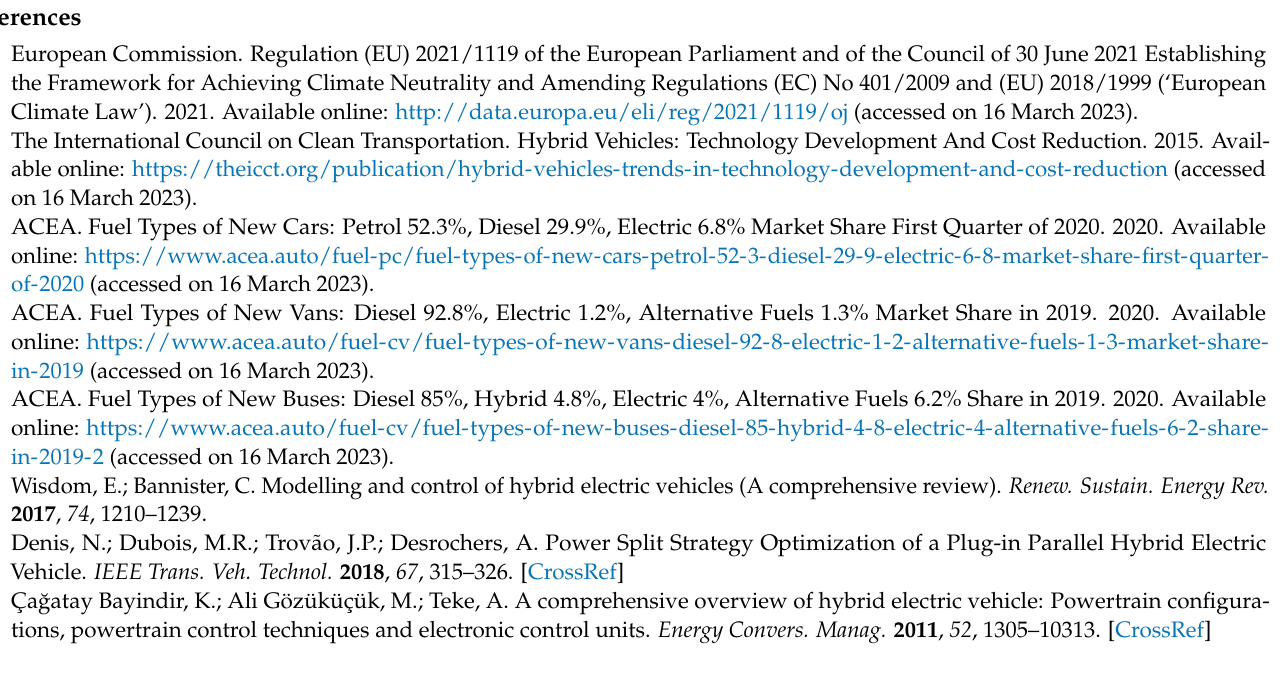
Figure A1. Powertrain configurations of the tested vehicles [22].